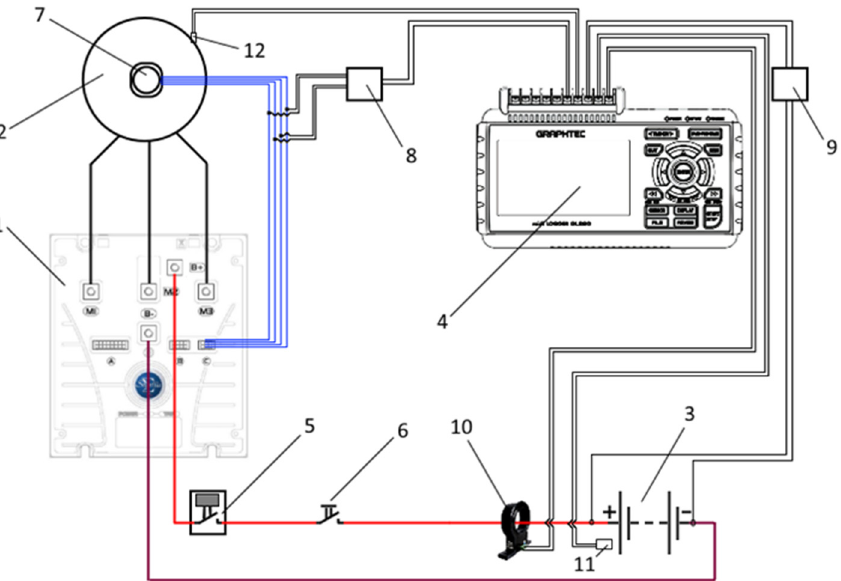
Figure 3. Electrical connections of test equipment: 1—Sigma Drive controller; 2—electric motor; 3—96 V battery pack; 4—data logger Graphtec GL220; 5—electromagnetic safety switch; 6—manual safety switch; 7—speed sensor; 8—frequency converter; 9—voltage sensor; 10—current sensor; 11 and 12—temperature sensors.